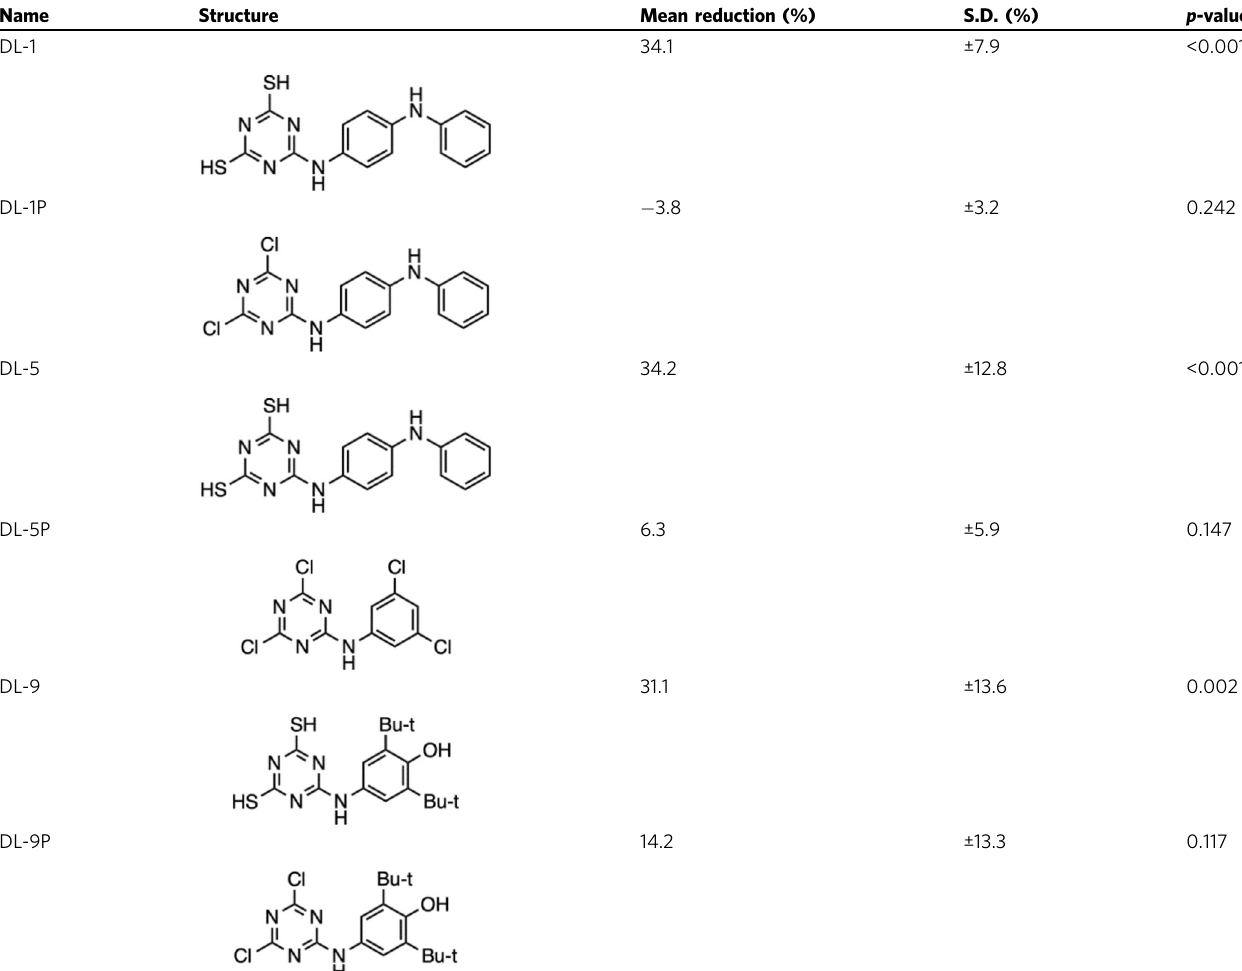
Table 2 Free thiol groups are critical for DL compound